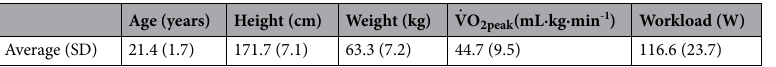
˙ VO 2peak ), and relative